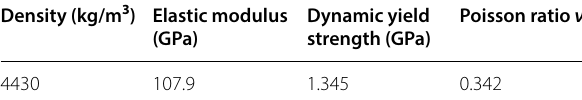
Table 2 Mechanical properties of TA2 titanium foils Density (kg/m 3 ) Elastic modulus (GPa)